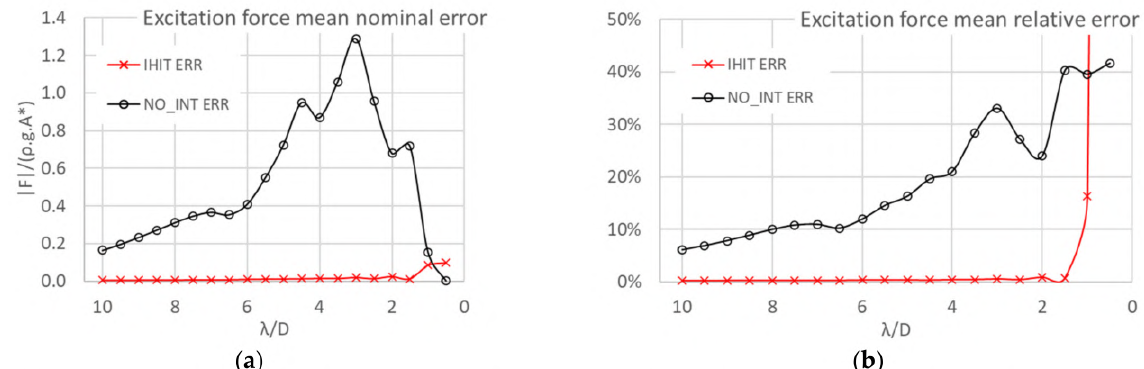
Figure 8. Mean error throughout the bodies for the excitation forces. “IHIT ERR” and “NO_INT ERR”, denote the mean error using the interaction theory with inhomogeneous wave field, and the mean error using the direct method only with an isolated body and body W 1 , respectively. The nominal error is the magnitude of the (complex) vector connecting the solution obtained with that of the multi-body reference direct method ( a ); the relative error is the nominal error divided by the magnitude of the reference value ( b ); the values in ( a , b ) correspond to averages of these